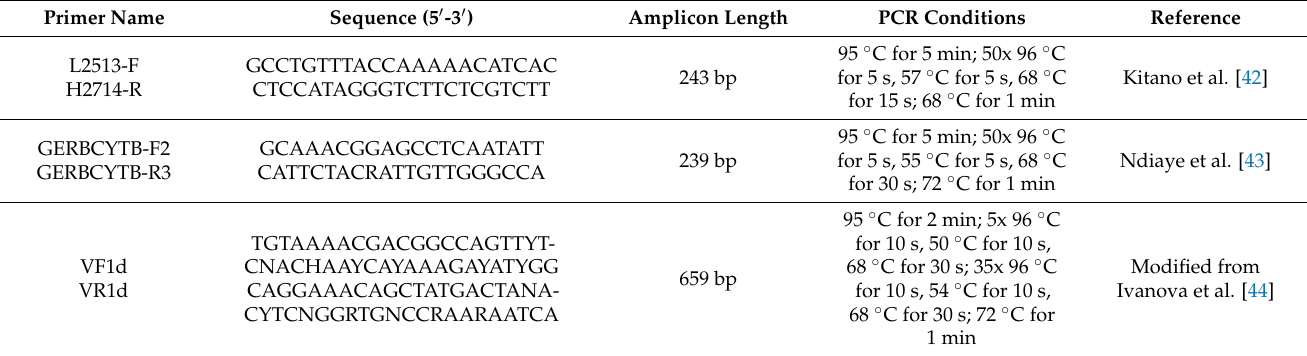
Table 2. PCR conditions and primers that were used for rodent species